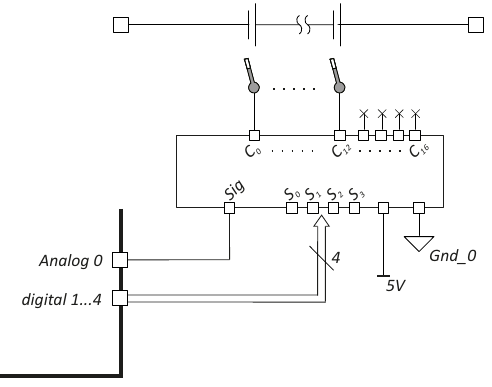
Figure 8. Representation of the electric circuit of the temperature acquisition system.